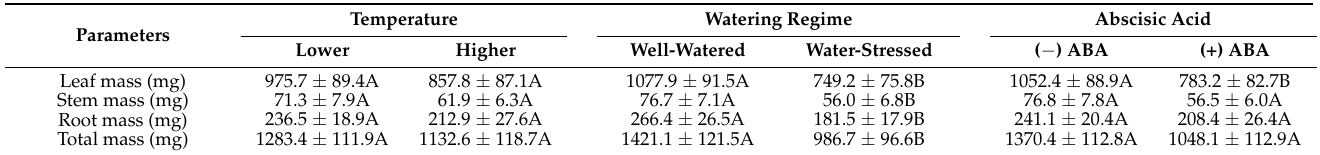
Table 6. Effects of temperature, watering regime, and abscisic acid on dry mass accumulation of tomato plants.